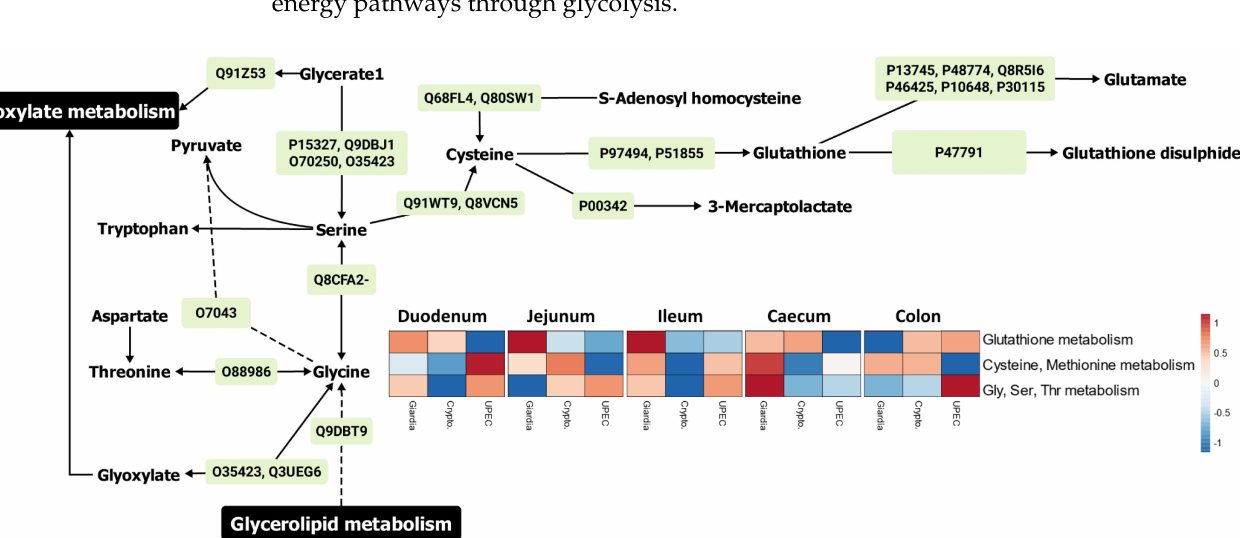
Figure 5. The major proteins (green boxes) and metabolites contributing to the sulphur-related redox metabolism in mouse gut during giardiasis. The heatmap represents relative upregulation (red) and downregulation (blue) of individual pathways in the mice with infected gut with respect to the uninfected mice. Note: The protein identifiers (green boxes) refer to the Uniprot IDs. The heatmaps were designed using the Clustvis web tool [24]. Details for major proteins (Figure S6) and metabolites (Table S2) are provided in the Supplementary